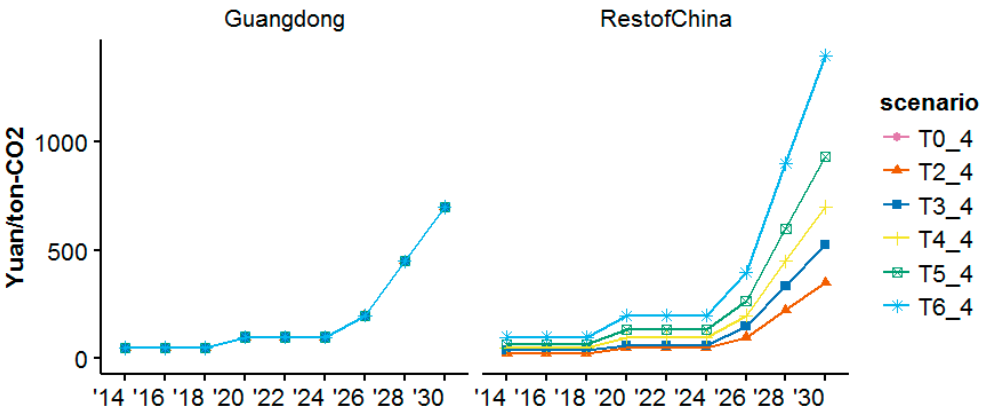
Figure 1. Carbon price in the GD and ROC region under the constraint of peak emission target in six reduction